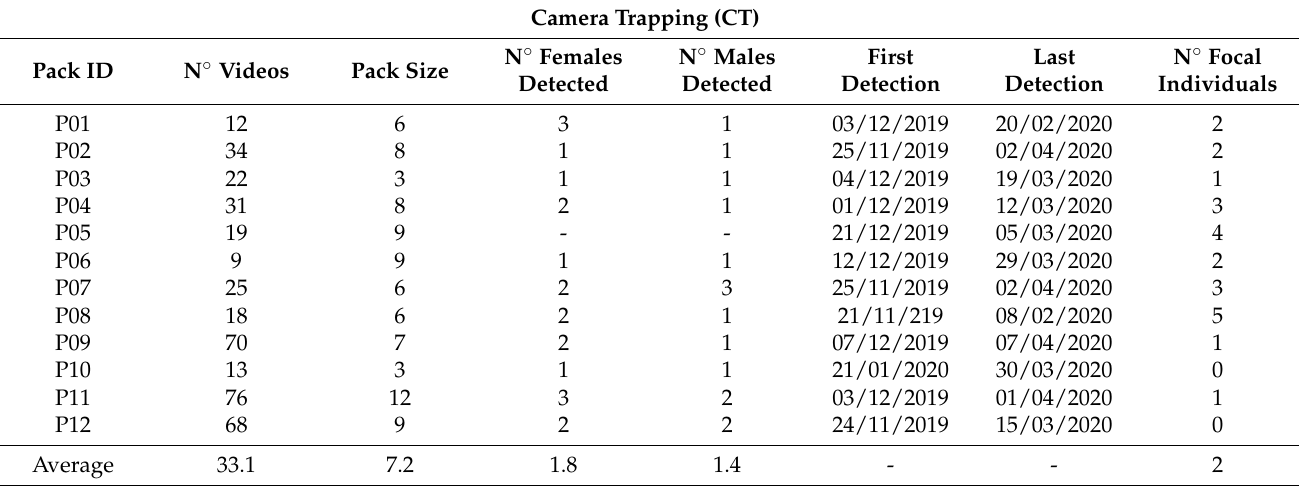
Table 4. Information on packs identified by camera trapping: number of videos per pack, minimum pack size, the minimum number of females and males identified, the temporal range of detections, number of focal individuals and their